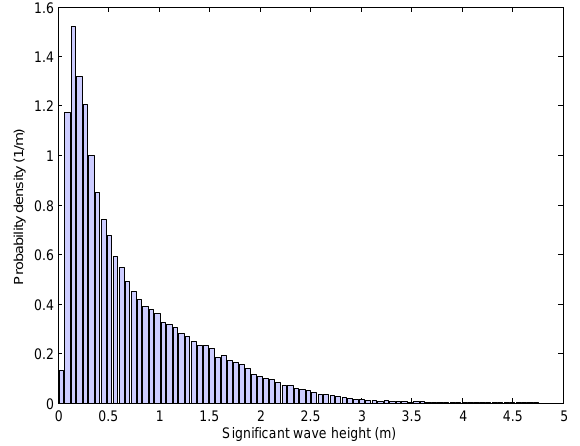
Figure 2. Histogram of the significant wave height H S at the Lysekil test site from the years 2005–2013.